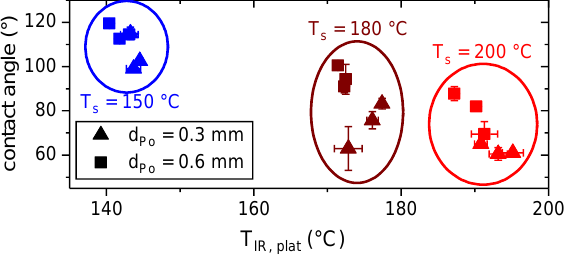
Figure 12. Contact angle as measured in light microscopic images (cf. Figure 11) as a function of plateau temperature, T IR, plat , for d Po = 0.3 mm and d Po = 0.6 mm high traces.